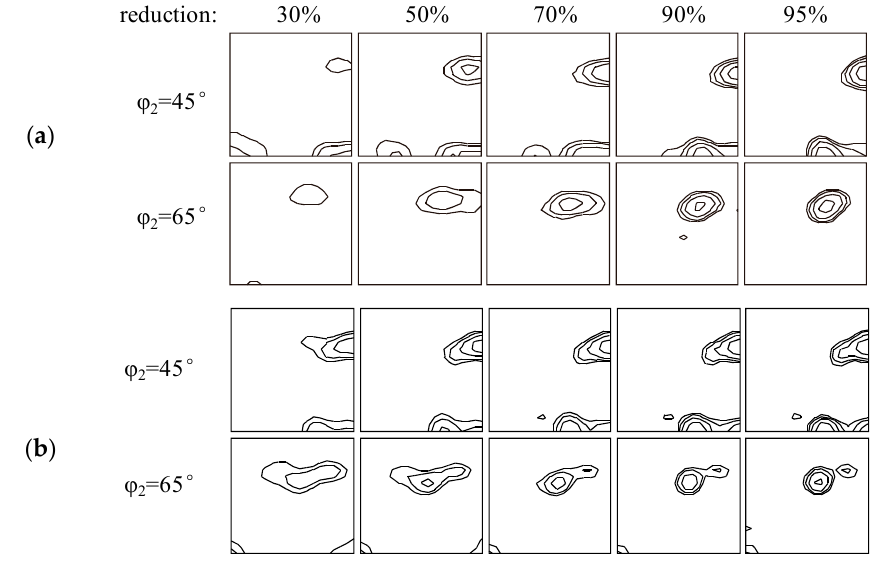
Figure 3. Development of rolling texture in commercial-purity aluminum and corresponding simulation based on the RS model, as observed in ODF ϕ 2 = 45 ◦ and ϕ 2 = 65 ◦ sections (density levels: 2, 4, 8 and 16). ( a ) Experimental texture; ( b ) corresponding texture simulation including 10% random texture (936 initial random orientations; simulation steps ∆ ε 33 = 0.001, α 12 = 0.72, α 23 = α 31 = 0, α 22 = 0.04), based on the RS model.